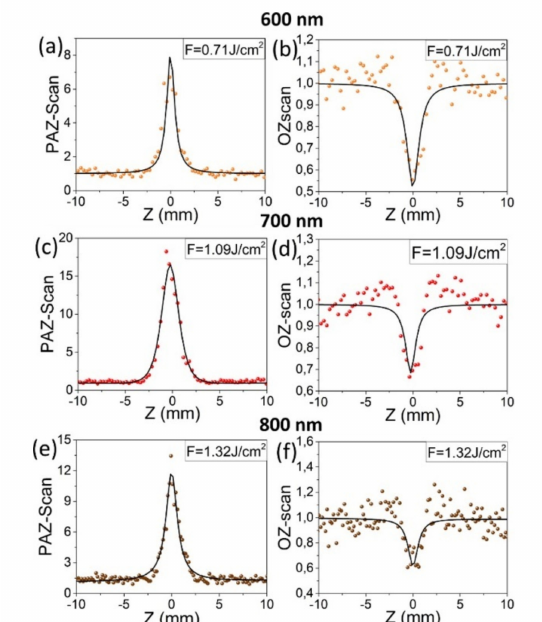
Figure 12. Experimental results (dots) and theoretical fits (lines) of the nonlinear absorption from TiN NP with the OPAZ setup. Left column ( a – c ), PAZ-scan measurements; right column ( d – f ), optical Z-scan with open aperture, simultaneously measured. Reprinted with permission from ref.